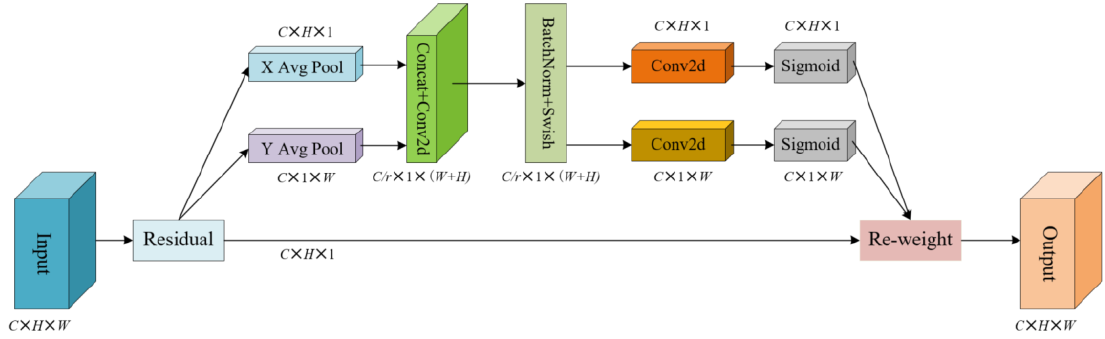
Figure 6. Architecture of CA module.